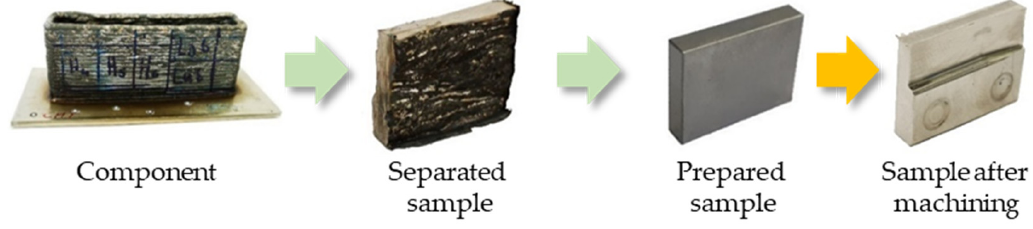
Figure 8. Sequence of sample preparation.